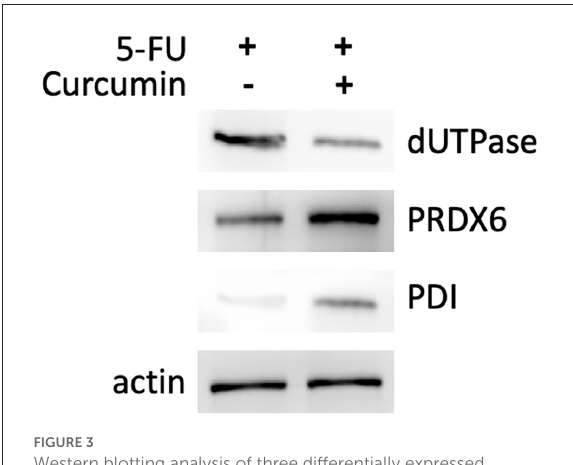
FIGURE3 Western blotting analysis of three differentially expressed proteins: PRDX6, PDI, and dUTPase. Differential expression of the protein of interest between SW480 cells treated with 5-FU (20 µ M) in combination with or without curcumin is normalized to actin level.